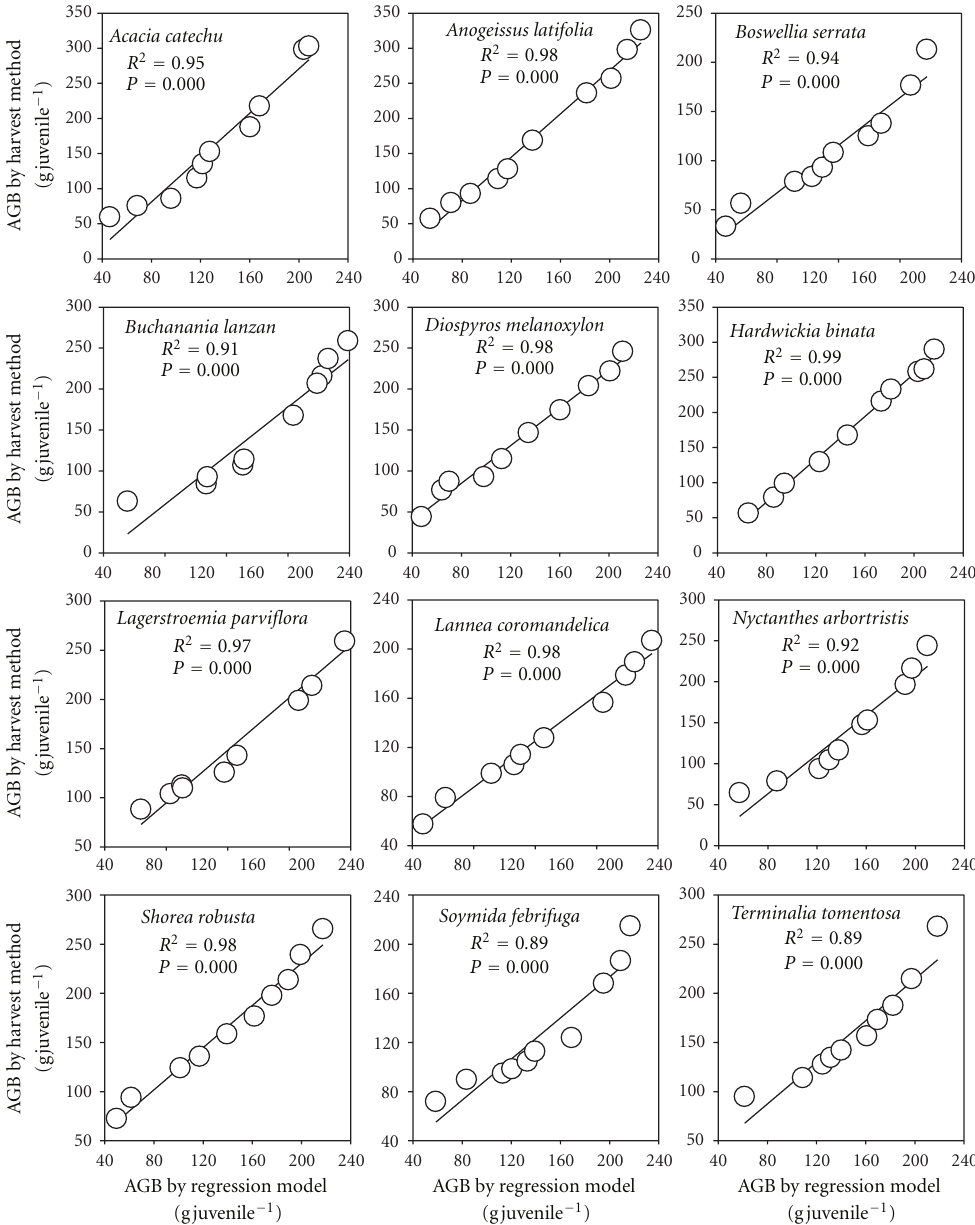
Figure 2: Relationships between the above ground biomass (AGB) of the dominant juvenile tree species estimated by allometric equation and by harvest